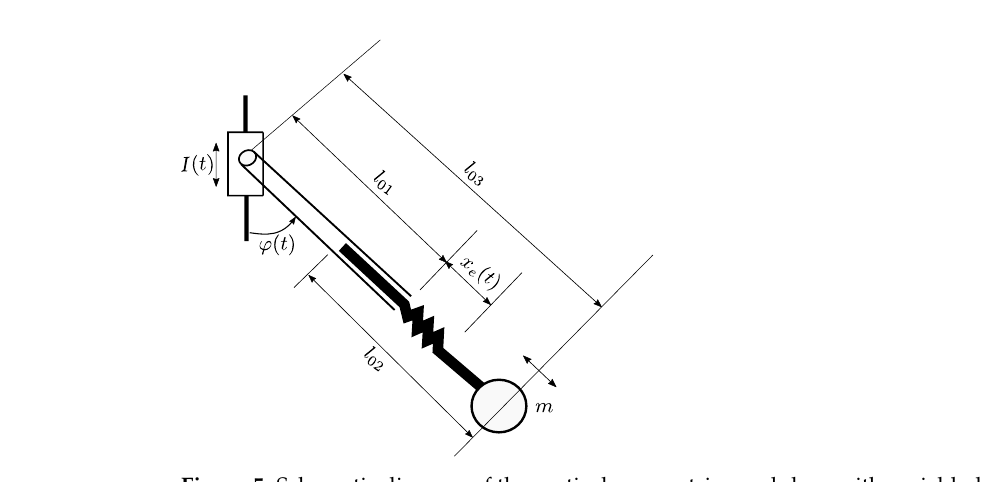
Figure 5. Schematic diagram of the vertical parametric pendulum with